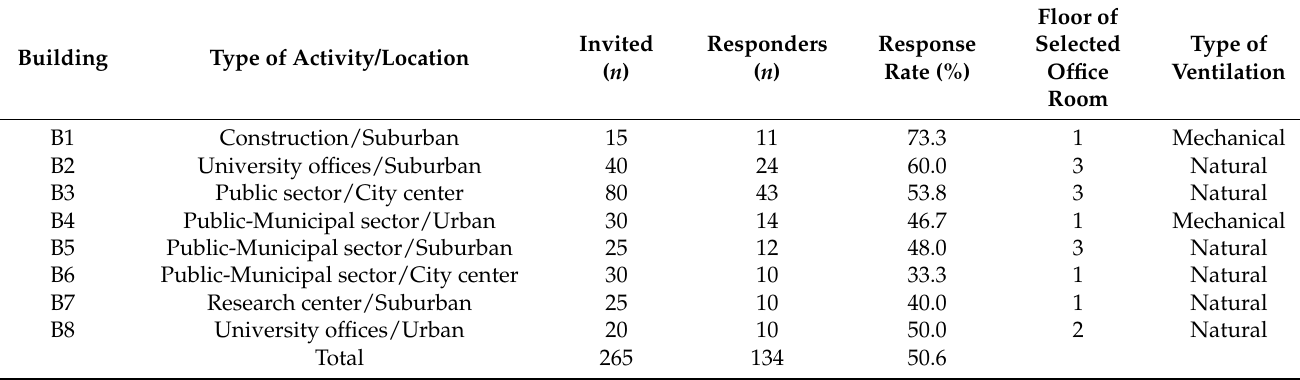
Table 1. Type of buildings and response